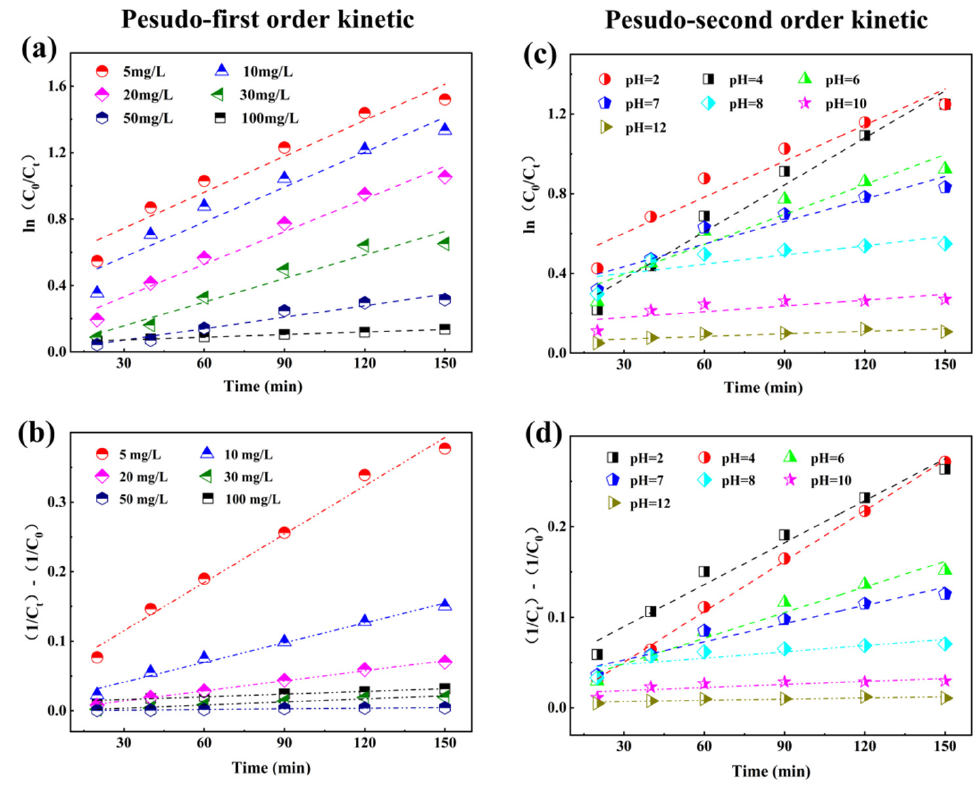
Figure 8. TC degradation of ( a ) pseudo-first-order kinetics and ( b ) pseudo-second-order kinetics with different TC concentration, ( c ) pseudo-first-order kinetics and ( d ) pseudo-second-order kinetics with different initial pH values. Table 2. TC degradation kinetics parameters with different TC initial concentrations.